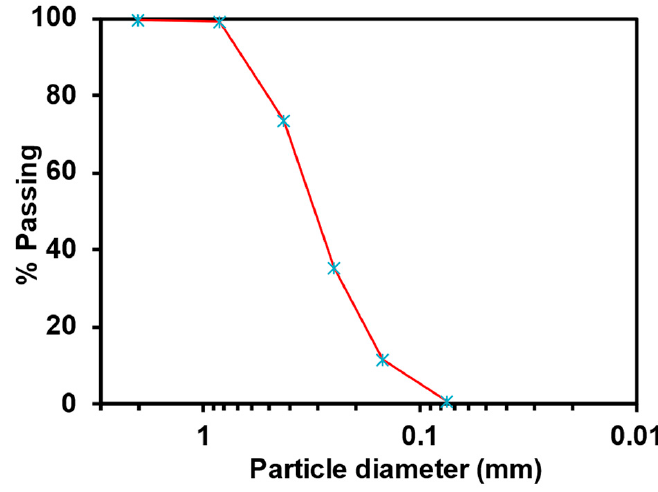
Figure 1. Particle-size distribution of the Thadiq Figure 1. Particle ‐ size distribution of the Thadiq sand.